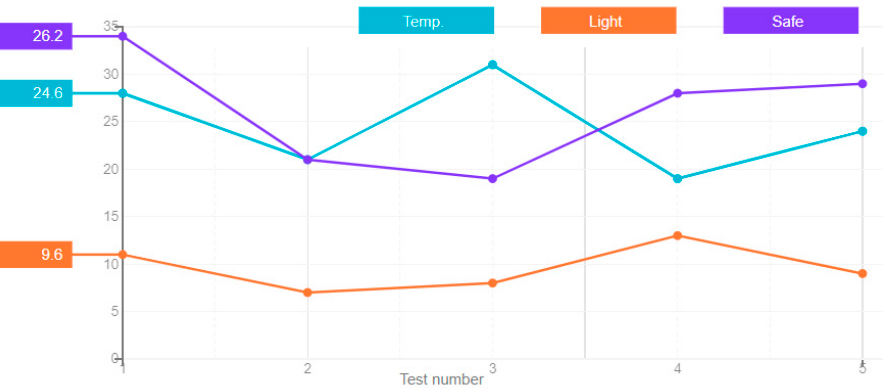
Figure 5. A chart of the recurrent neural network’s error values.